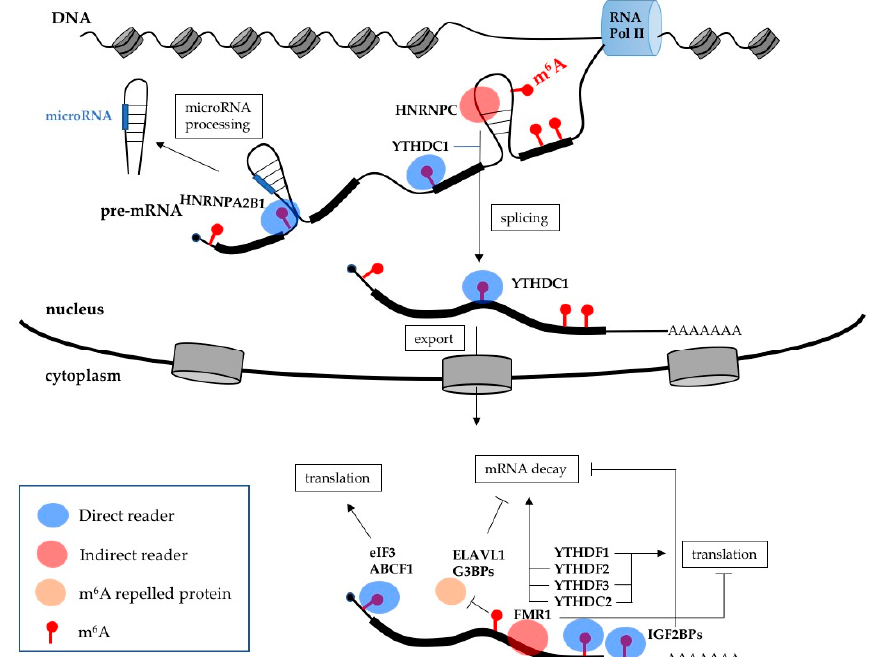
Figure 2. Functional roles of m 6 A modification on mRNA expression. Most of m 6 A’s effects on